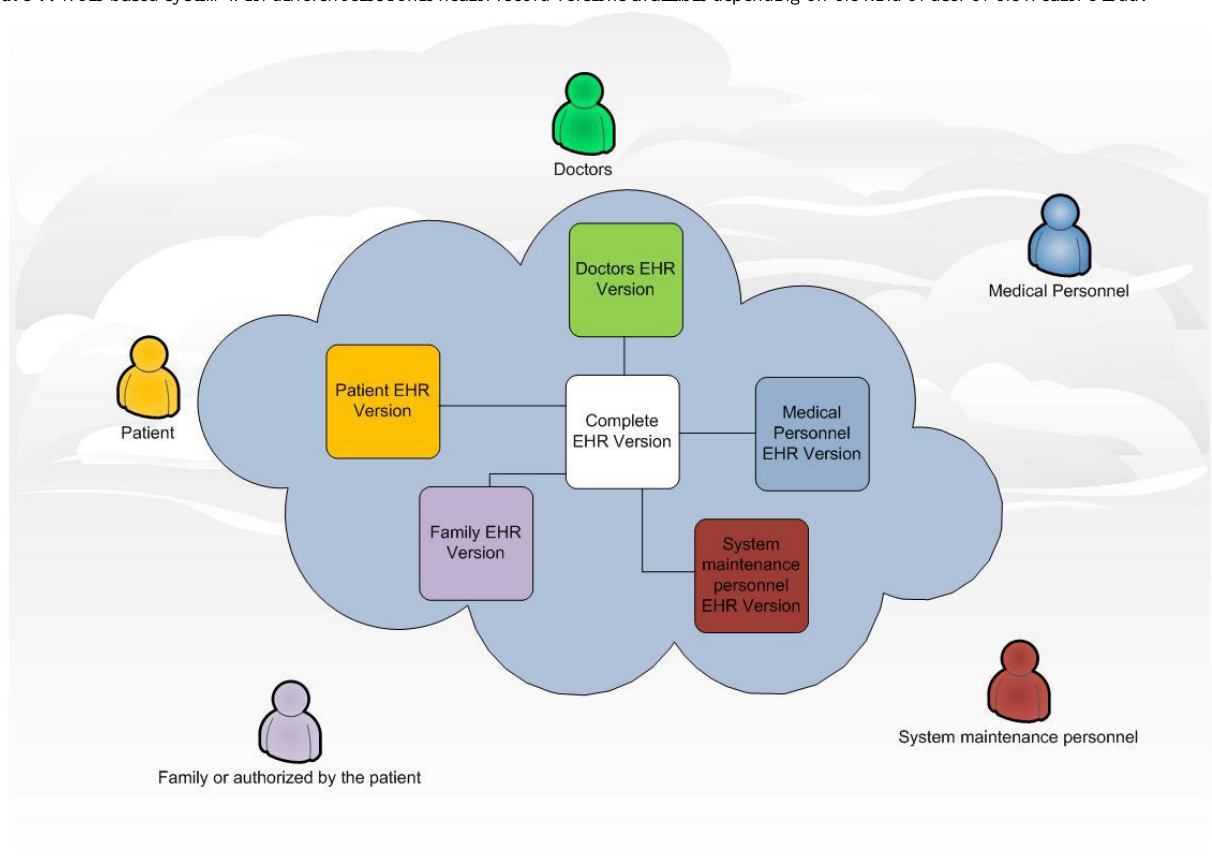
Figure 1. Role-based system with different electronic health record versions available depending on the kind of user of the Health